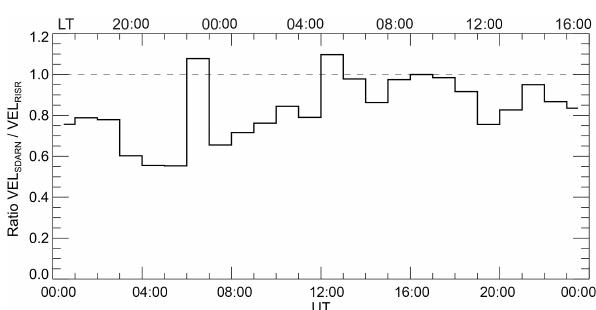
Figure 4. Line plot of the hourly median velocity ratio R versus UT for the CLY radar. The data set is the same as for Fig. 3a. For the area of observations, local time (scale at the top) roughly coincides with the magnetic local time.